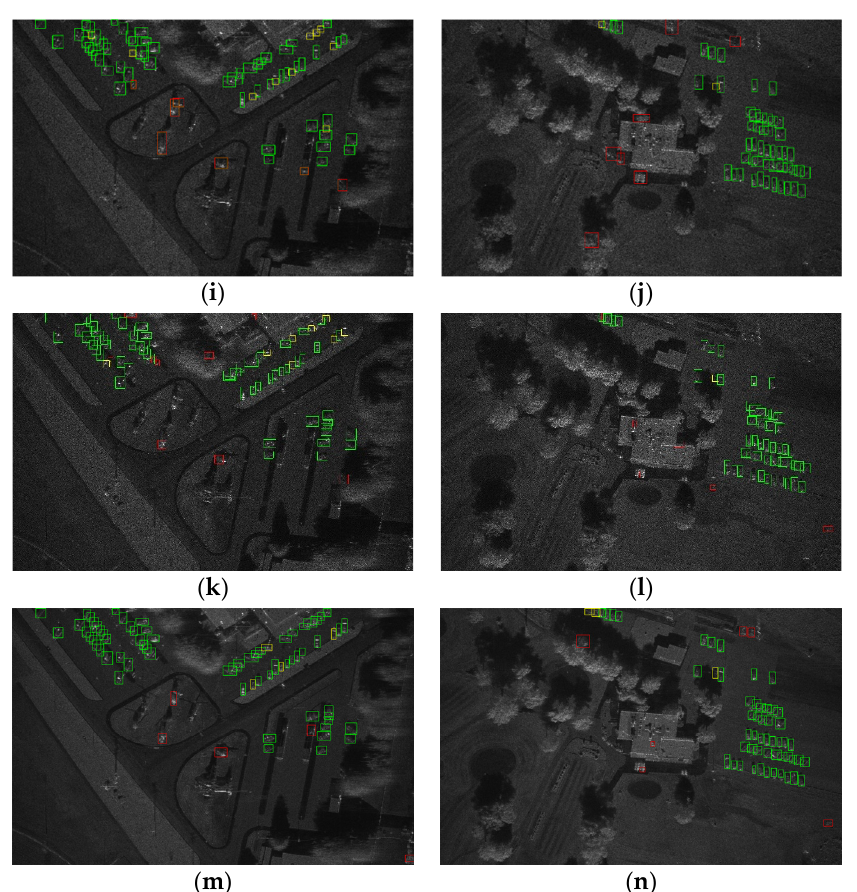
Figure 5. The target detection results compared with other detection methods for Images I and II, where green, red, and yellow rectangles represent the detected target chips, false alarms, and missing alarms, respectively. ( a , b ) the two-parameter CFAR method, ( c , d ) the Gamma CFAR method, ( e , f ) the Faster RCNN, ( g , h ) the original SSD, ( i , j ) the DA-TL SSD, ( k , l ) the RefineDet, ( m , n ) the proposed target detection method.